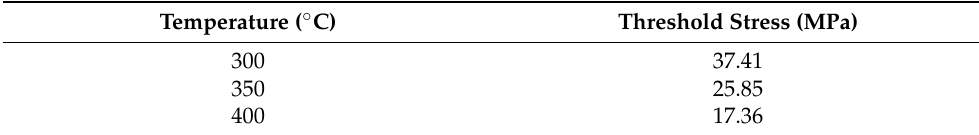
Figure 9. Calculation results of the threshold stress for the creep of the ABOw/Al–12Si composite. Table 5. Values of the threshold stress estimated by the extrapolation technique for the ABOw/Al– 12Si